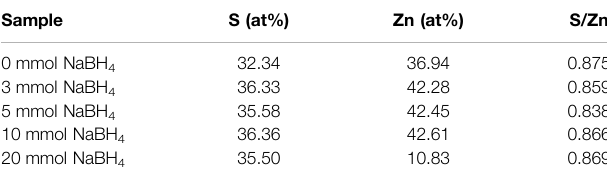
TABLE 1 | Chemical composition of ZnS samples measured via XPS. Sample S (at%) Zn (at%) S/Zn